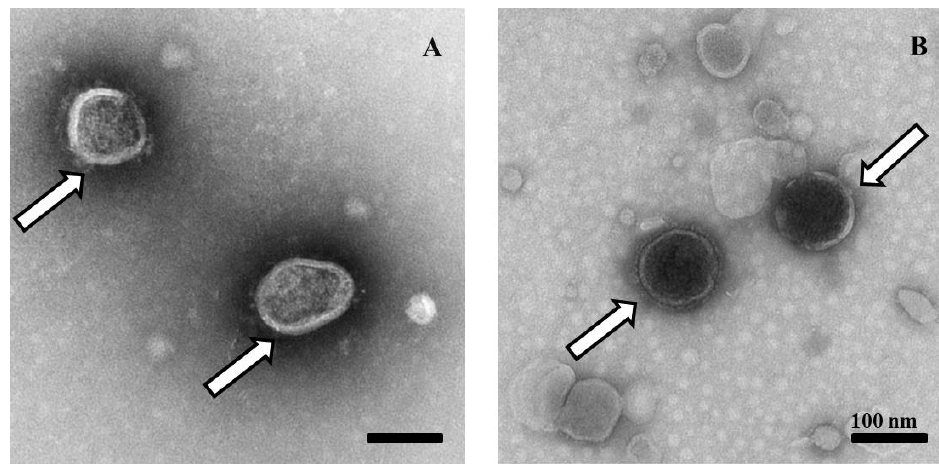
Figure 3. Transmission electron microscopy (TEM) observation on purified rNDV-IBV-T / B and LaSota strains. ( A ) The 20 th passage (P20) of rNDV-IBV-T / B, which appears as circles or ovals about 100 to 150 nm in diameter. ( B ) The control parental LaSota virus showed circular particles and the surface of the NDV was characterized by an envelope. Virions are marked by arrows. Scale bar = 100 nm.